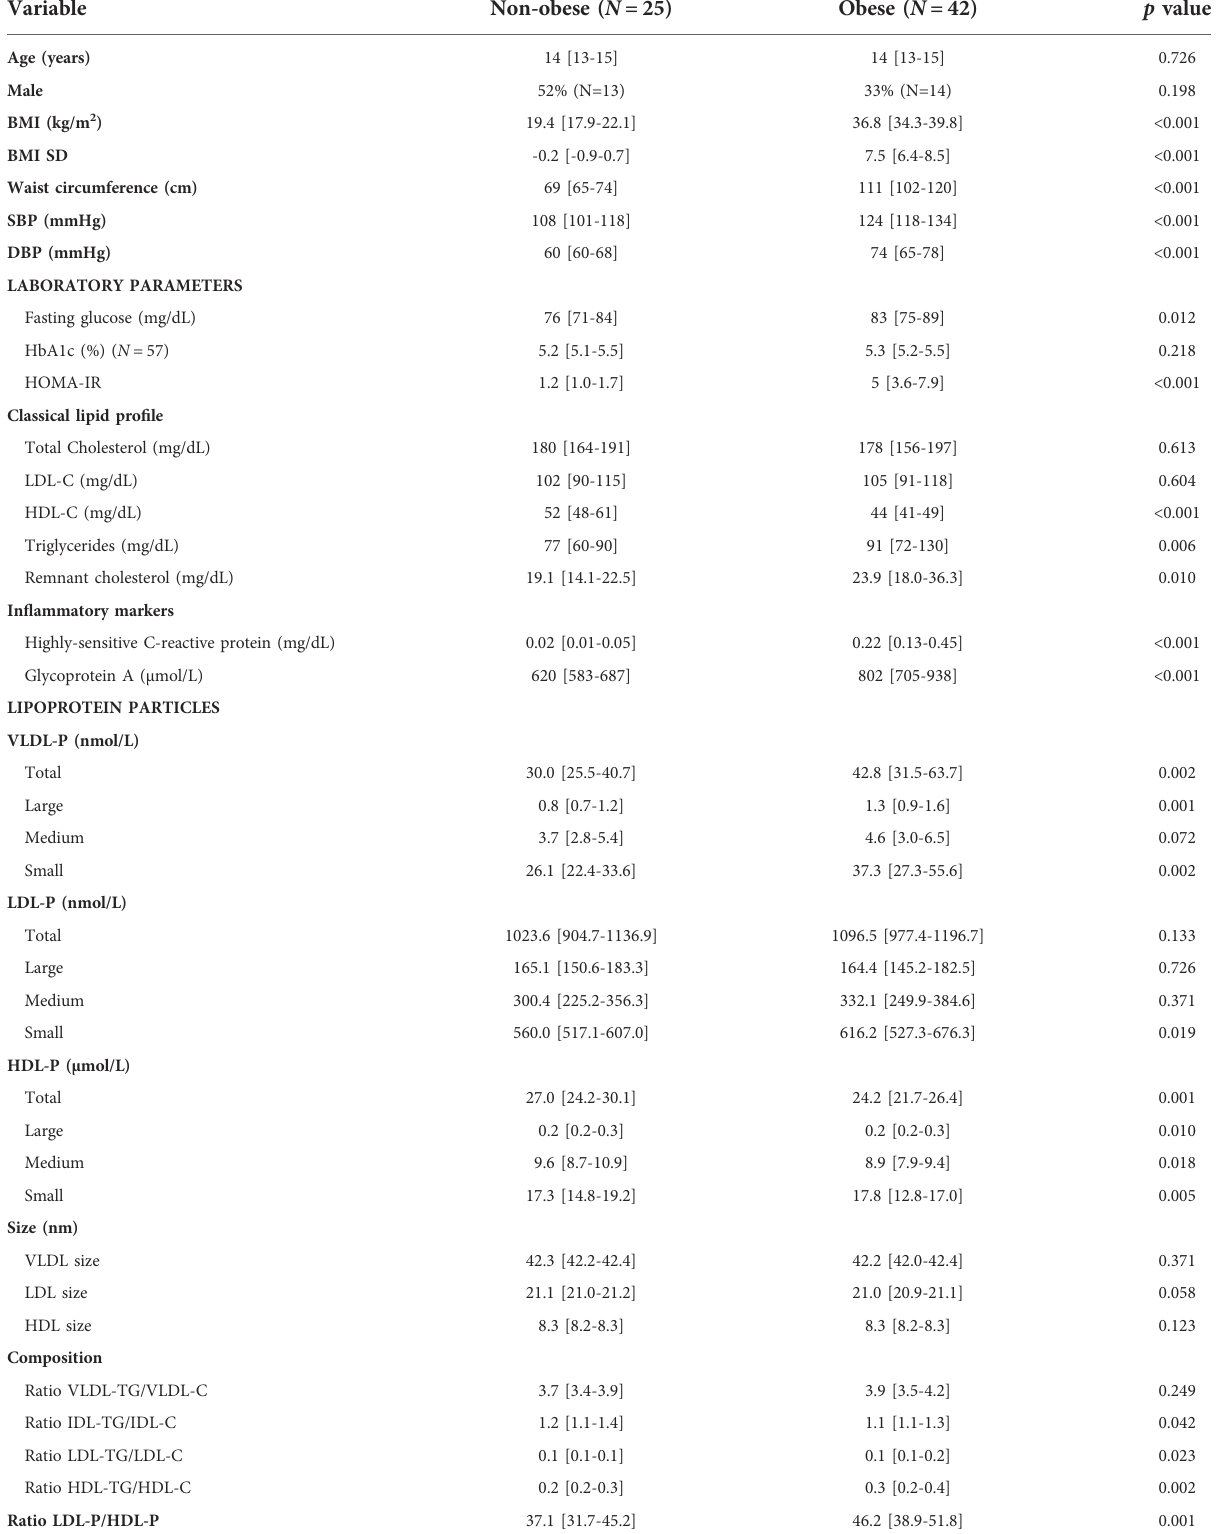
TABLE 2 Clinical and laboratory characteristics of subjects depending on body mass index